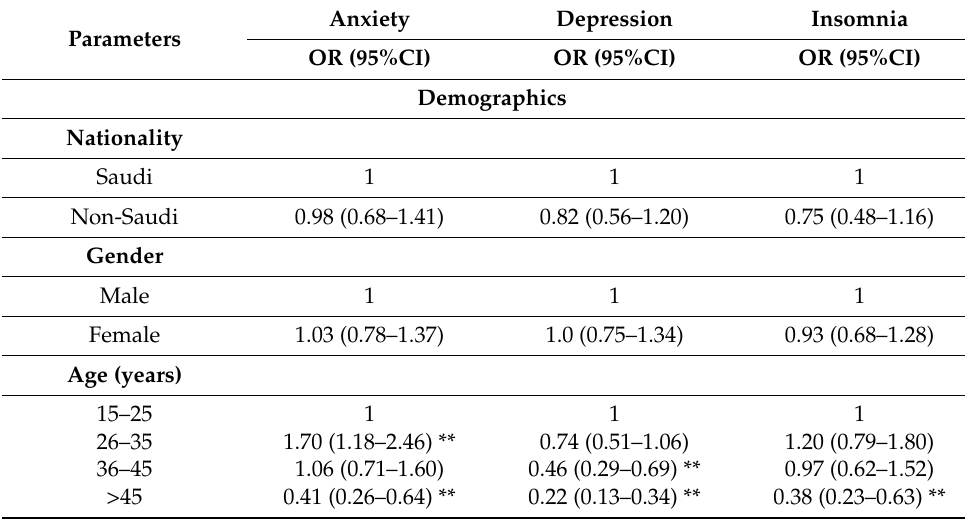
Table 3. Predictors for anxiety, depression, and